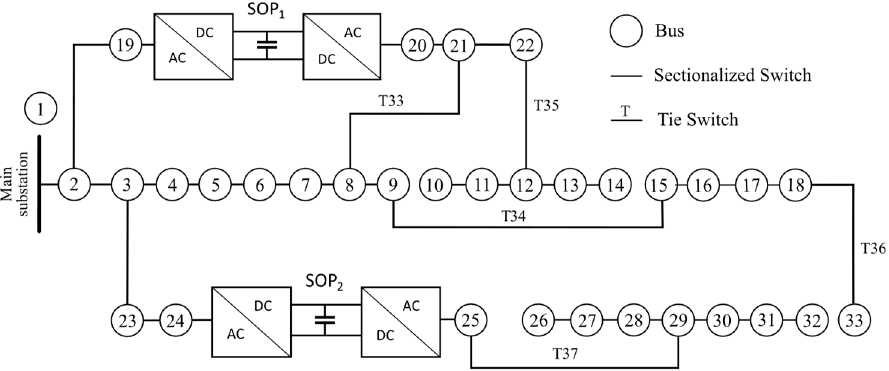
Figure 5. The optimal SR and two SOP locations for the IEEE 33-node radial DS.